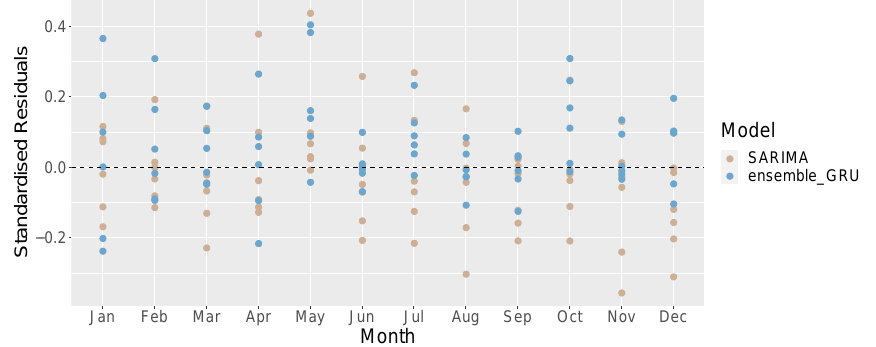
Figure 8. Standardised residuals of the SARIMA and GRU models for the different months.